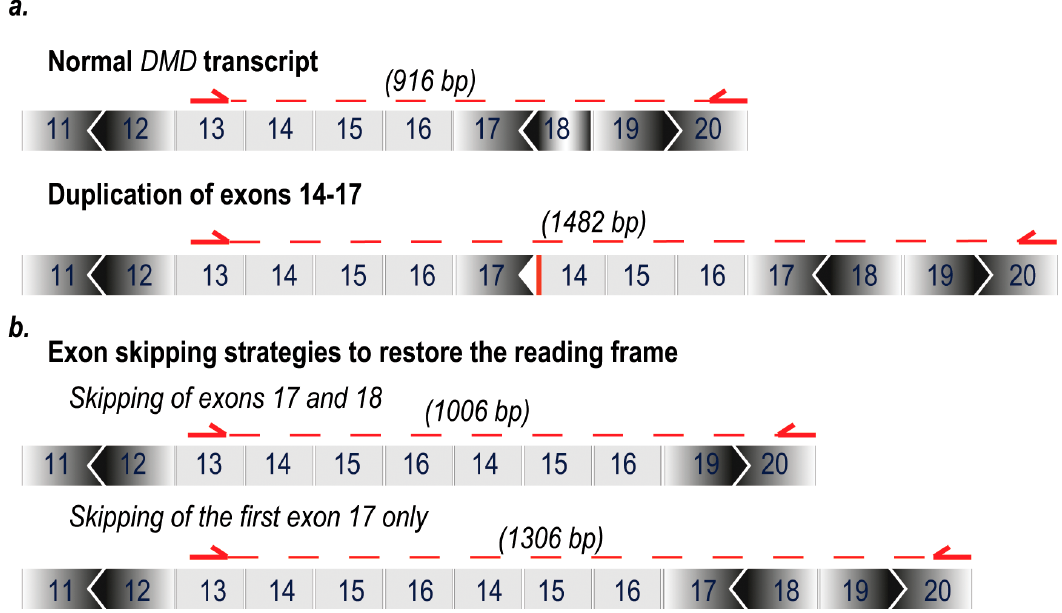
Figure 1. Antisense oligomer (AO) mediated exon excision strategies to restore dystrophin expression in the presence of frame-shifting exon duplications. AO strategies targeting exons 17 and 18 to generate a truncated yet in-frame dystrophin transcript. ( a ) Normal dystrophin exon arrangement and reading frame disrupted by a duplication of exons 14–17; ( b ) excision of exons 17 and 18 in a DMD transcript with an exon 14–17. Excision of only the first copy of exon 17 from dystrophic cells with an exon 14–17 duplication. Arrows and dotted line indicate predicted PCR amplicon sizes.